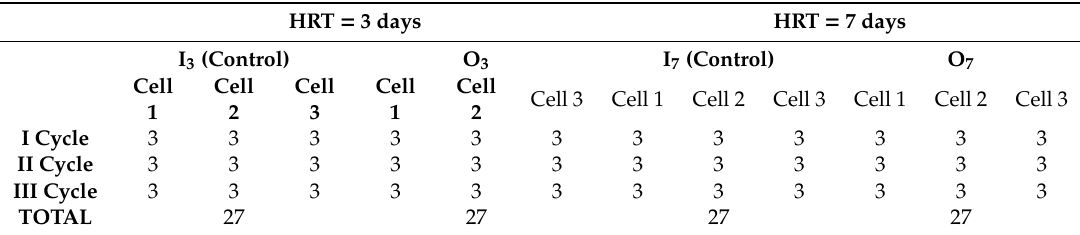
Table 1. Sampling strategy for wastewater. Samples collected for both hydraulic retention times